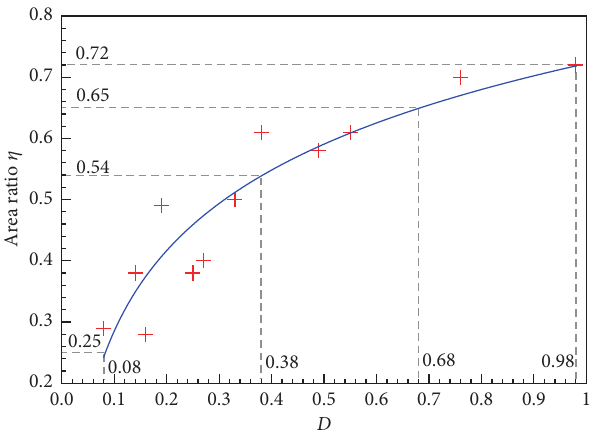
Figure 6: Fitting curve of D and η. Table 6: Test arrangement of the parameter w